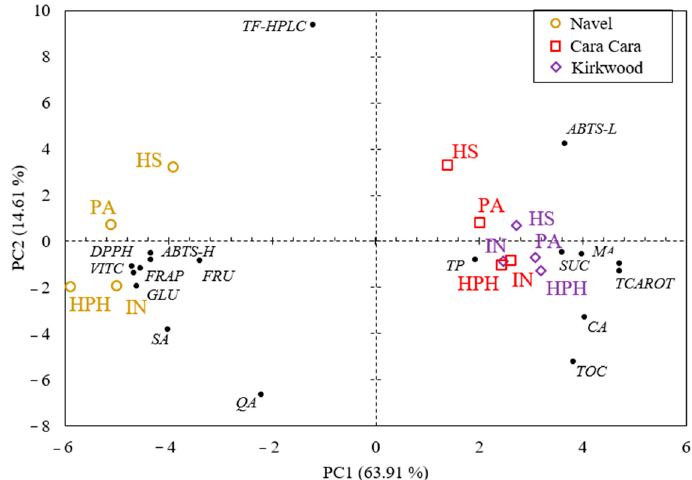
Figure 8. Principal component analysis (PCA) of total carotenoids (TCAROT), vitamin C (VITC), tocopherols (TOC), total phenolics (TP), total flavonoids by HPLC (TF-HPLC), sucrose (SUC), glucose (GLU), fructose (FRU), citric acid (CA), malic acid (MA), succinic acid (SA), quinic acid (QA) and antioxidant capacity (DPPH, FRAP, ABTS-H, and ABTS-L) in hand-squeezed (HS), industrial (IN), high-pressure homogenized (HPH) and pasteurized (PA) juices of N (yellow circles), CC (red squares) and K (purple diamonds) orange.